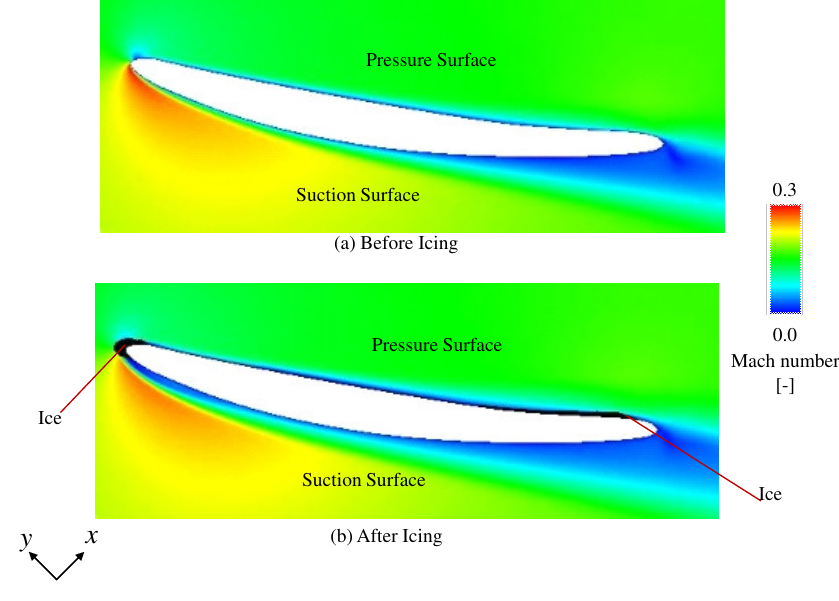
Figure 6. Mach number distribution at 90% span of the fan for Case